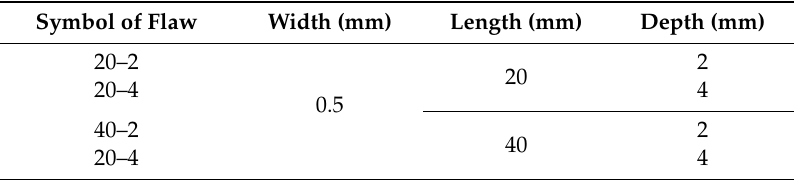
Figure 7. Specifications of test piece (units in mm). Table 2. Size of flaws on test piece